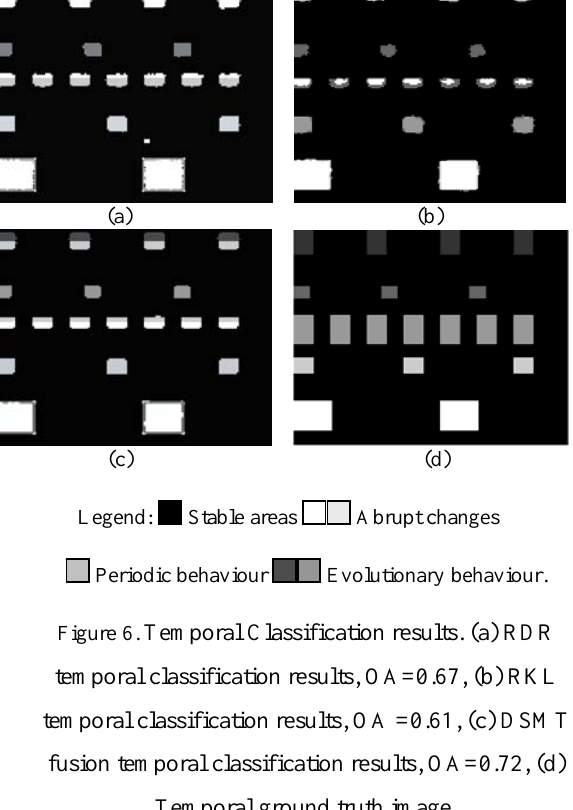
Figure 8. The resulted non filtered and filtered Reference image for real